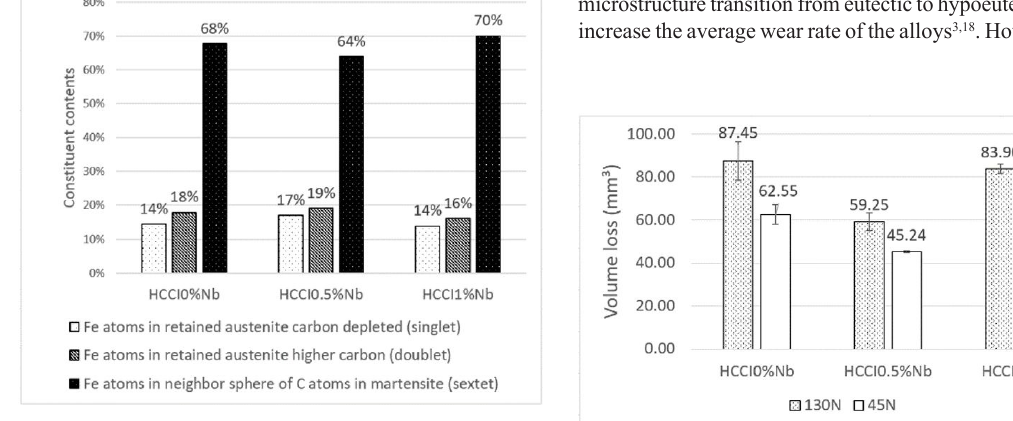
Figure 9. Retained austenite and martensite contents in the matrices obtained by Mössbauer spectroscopy.